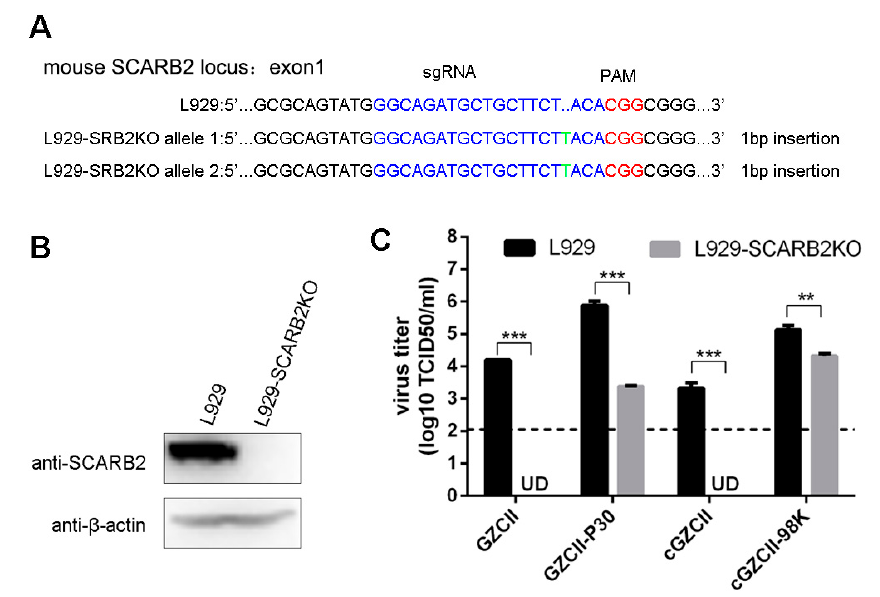
Figure 4. Viral replication in SCARB2-knockout L929 cells. ( A ) Construction of a SCARB2-knockout cell line. Both alleles of L929-SCARB2KO cells were genotyped by Sanger sequencing to confirm SCARB2 gene disruption. ( B ) Expression of SCARB2 in wild-type L929 or L929-SCARB2KO cells was detected by western blotting. GZCII mutants were used to infect L929 and L929-SCARB2KO cells (MOI = 0.1). Viral titer ( C ) at 24 h post-infection were detected by TCID 50 method. (**: p < 0.01; ***: p < 0.001).